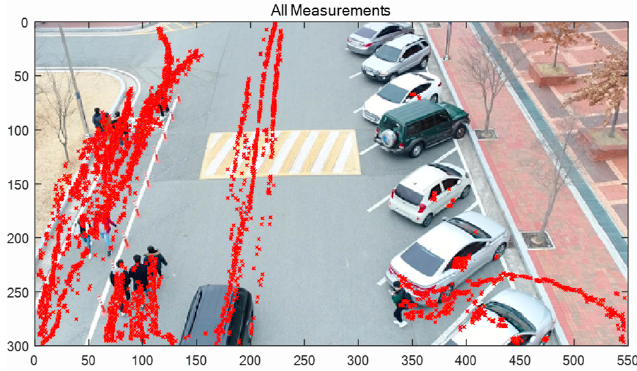
Figure 10. Measured positions, including false alarms.